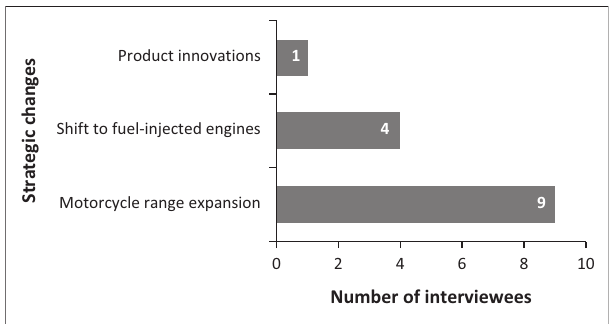
1 FIGURE 4: Most apparent strategic